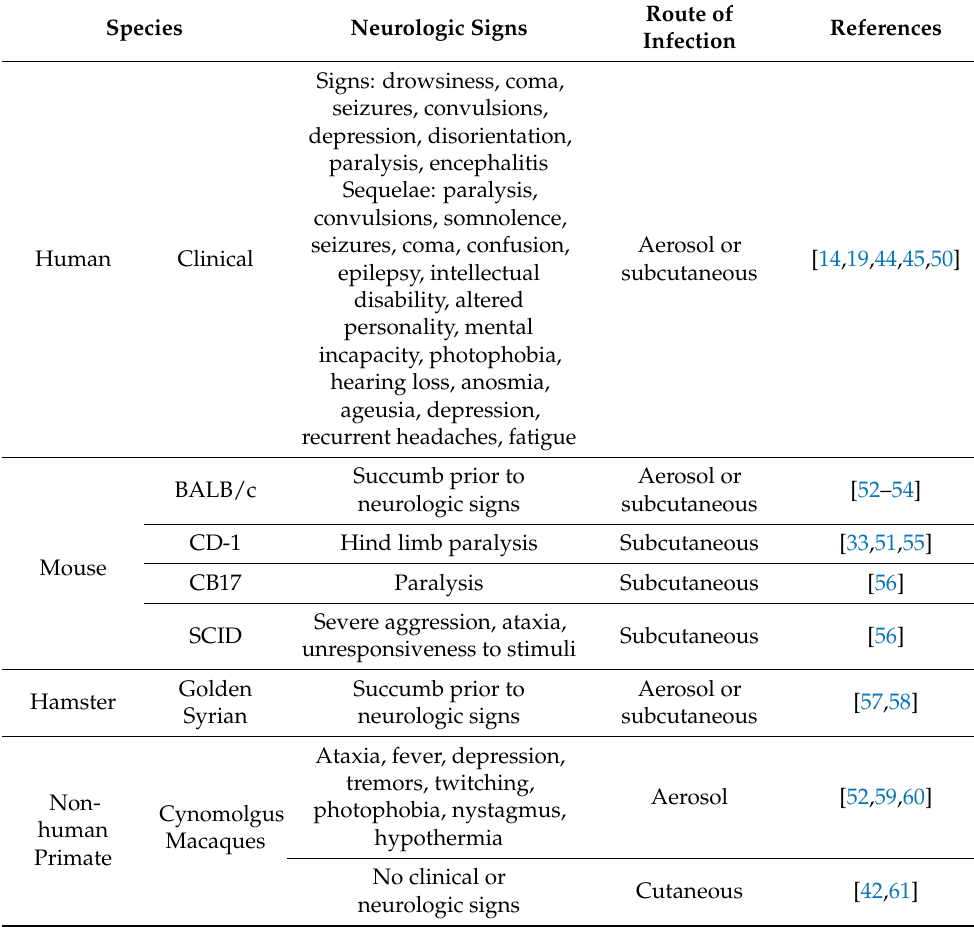
Table 2. Clinical and animal modeling of neurologic disease with Venezuelan equine encephalitis virus (VEEV)